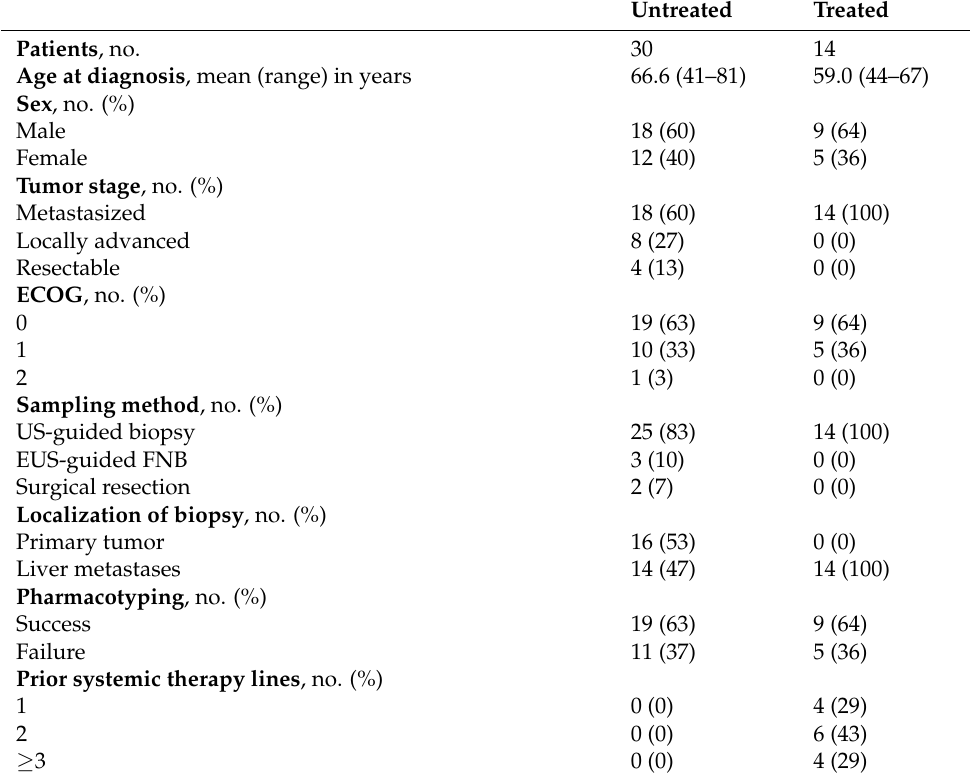
Table 1. Characteristics of pancreatic cancer patients. No, number; ECOG, Eastern Cooperative Oncology Group; US, ultrasound; EUS, endoscopic ultrasound; FNB, fine needle biopsy; PDO, patient-derived organoid; FOLFIRINOX, 5-fluorouracil, leucovorin, irinotecan, and oxaliplatin; OFF, 5-fluorouracil, leucovorin and oxaliplatin; nab-p, nab-paclitaxel; nal-iri/5-FU, nanoliposomal irinote- can, 5-fluorouracil and leucovorin, FOLFOX, 5-fluorouracil, leucovorin, and oxaliplatin; Doce/Ox, Docetaxel, and oxaliplatin; CR, complete response; PR, partial response; PD, progressive disease; SD, stable